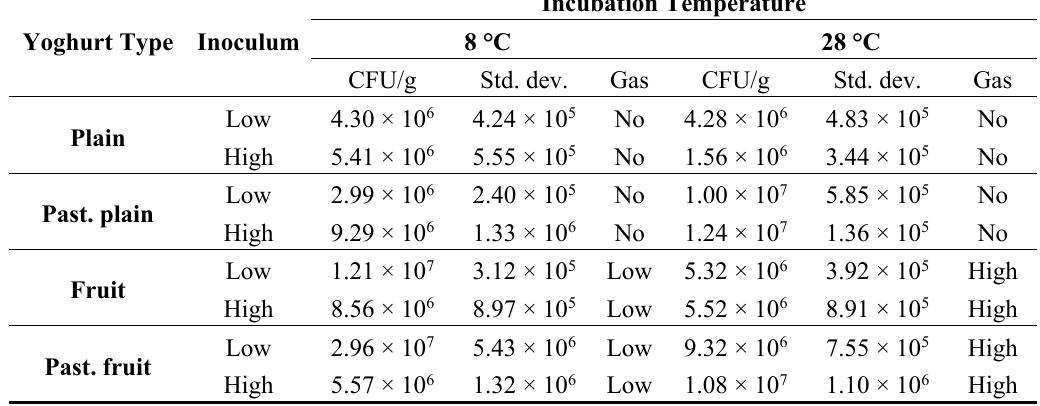
Table 3. Artificial lab-inoculated yogurts, final CFU/g and gas produced in yogurts with low (4 CFU/g) and high (400 CFU/g) inocula after incubation at two temperatures. Yoghurt Type Inoculum